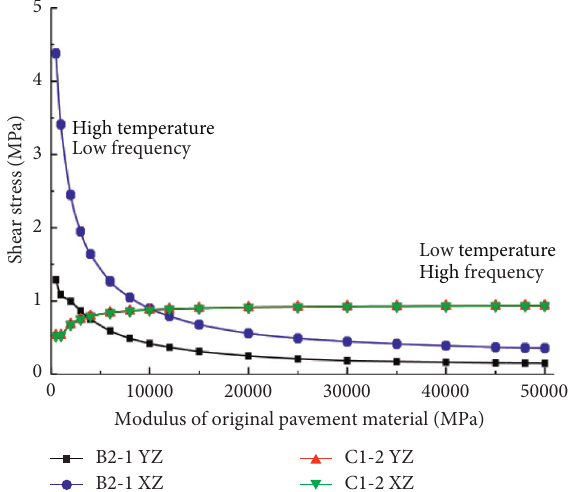
Figure 26: The effect of original pavement material modulus on shear stress of joint filling